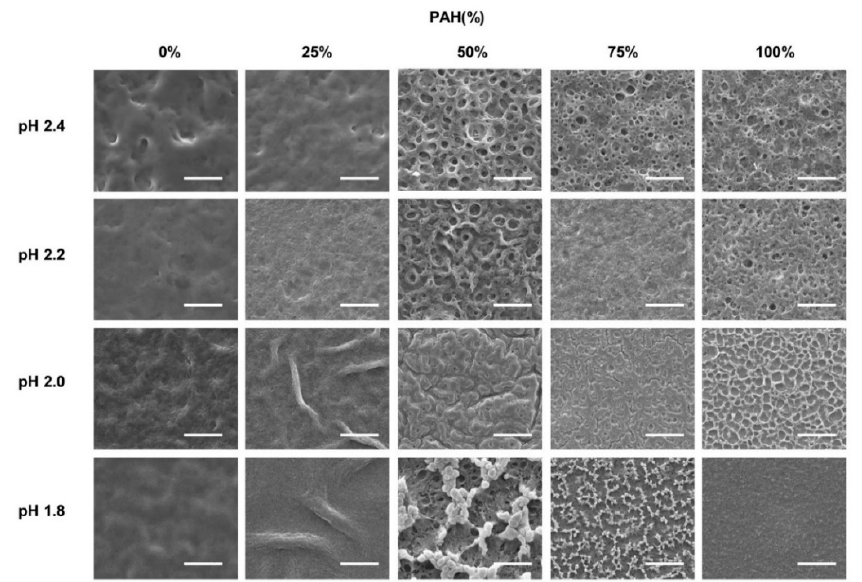
Figure 2. SEM images of LbL films of varying BPEI/PAH ratios acid-treated at varying pHs. Acid- treatment time was fixed at 1 h. The scale bars are 20 μ m.